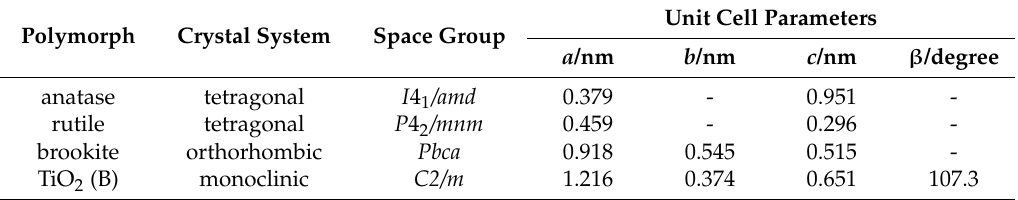
Table 1. Structural parameters of the main TiO 2 polymorphs. Date reproduce from reference [9], with permission of the American Chemical Society,